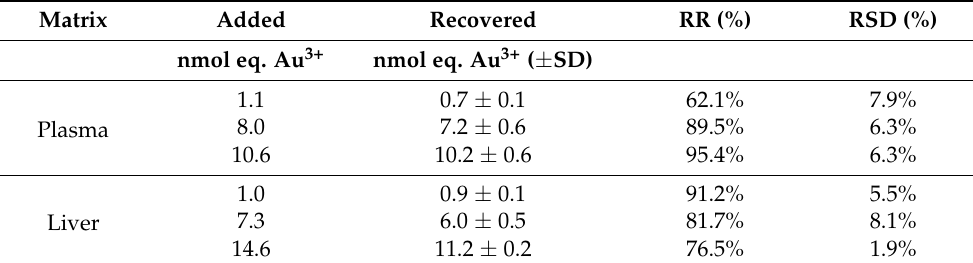
Table 3. Au 3+ recovery and repeatability obtained after the addition of various quantities of Au 3+ issued from diluted AuNP suspensions in 100 µ L of rat plasma or added to 250 mg of rat liver ( N = 3). Matrix Added